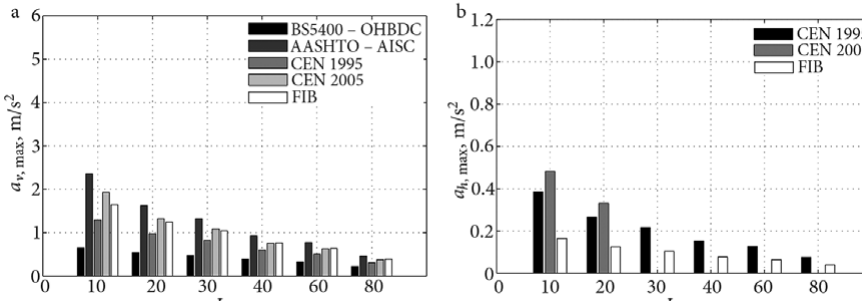
Fig. 6. Vertical and lateral accelerations induced by a single resonant walker